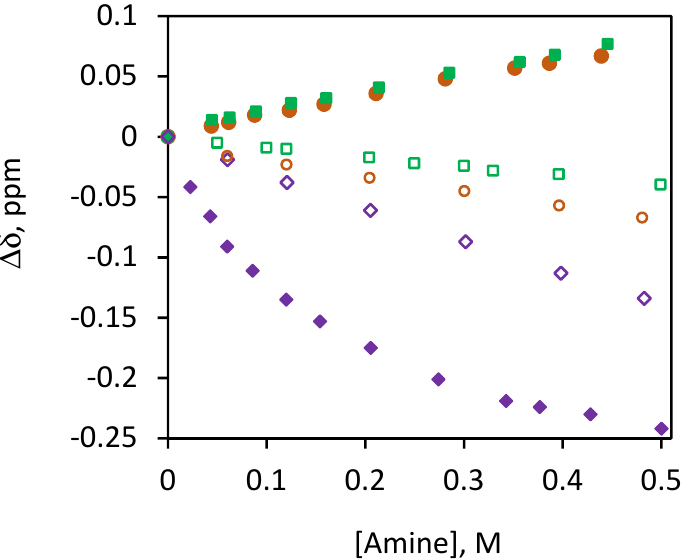
Figure 3. Dependencies of the chemical shifts in the proton of CHI 3 ( ◇ ), CHBr3 ( ο ) and CHCl 3 ( □ ) (as compared to that in the corresponding isolated molecules) on the concentration of DABCO (filled symbols) or TMPD (open symbols) (in CD 3 CN, 22 °C).